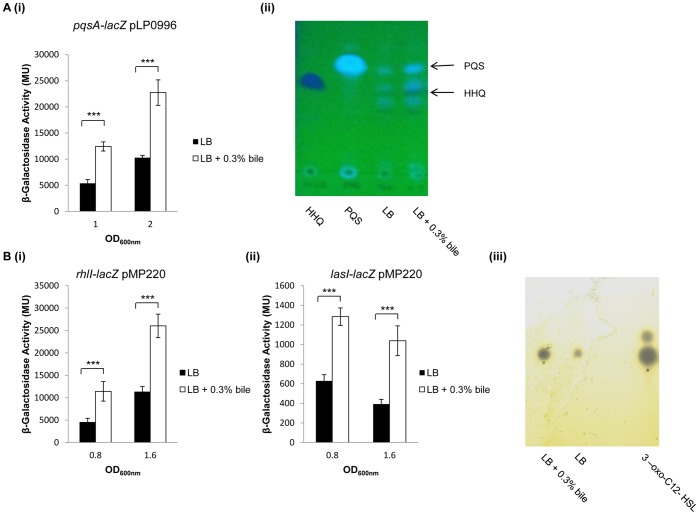
QS is triggered in response to bile.(A)(i) Promoter activity of the pqsA-E biosynthetic operon was significantly increased in the presence of 0.3% bile (p<0.005). (ii) TLC analysis of supernatant extracts from cells grown in the presence and absence of 0.3% bile revealed that the increased expression of the pqsA-E operon in the presence of bile results in increased production of the HHQ and PQS signal molecules. Synthetic HHQ and PQS were loaded as controls to facilitate identification of the signal molecules in the supernatant extract. (Bi & ii) Promoter activity of the rhlI and lasI AHL QS systems was also significantly increased in the presence of 0.3% bile (p<0.005). As with the PQS system, increased promoter activity was evident in early and late exponential phase growth. (Biii) Reversed phase TLC analysis of supernatant extracts taken from bile treated and un-treated PA14 cells grown in LB, and overlaid with soft agar containing the C. violaceum CV026 long chain AHL biosensor strain. Increased production of the long chain AHLs can clearly be seen in the treated sample corresponding to the position of the 3-oxo-C12-HSL standard (25 µg). All experiments were performed in triplicate and data presented is representative of at least three independent biological replicates.